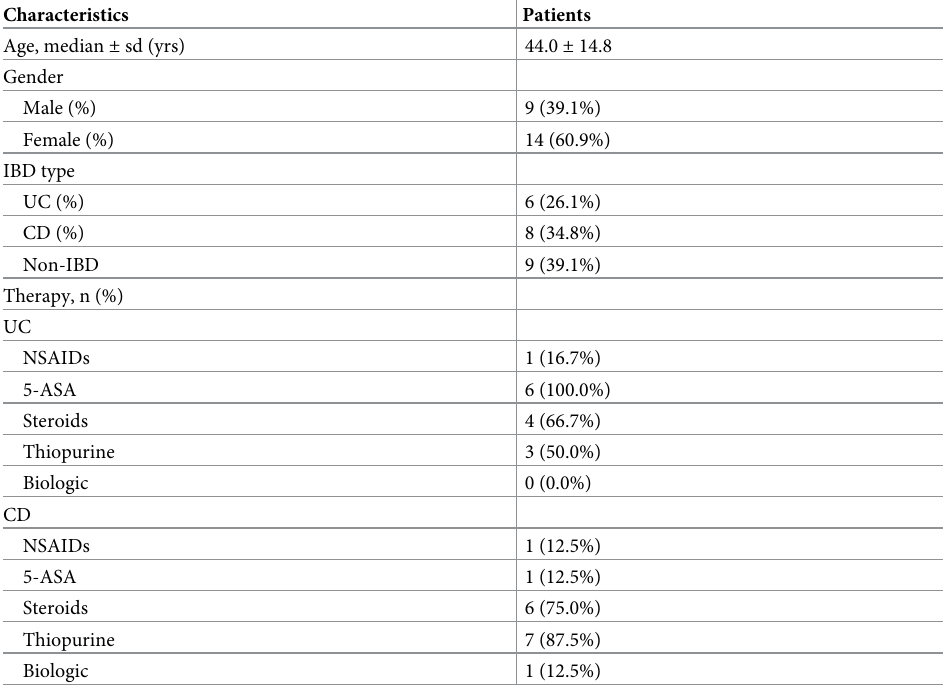
Table 4. Demographics of patients included in the exploratory analysis of pre- vs. post-biologic therapy and patients without IBD (healthy